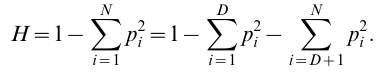
Table S1 Data set used for Example 1. There are four binary sites and 30 haplotypes. The first haplotype, haplo1, is a singleton, the second is the most prevalent occurring 12 times while there are four copies of the third (haplotypes 3,4, 16 and 18).